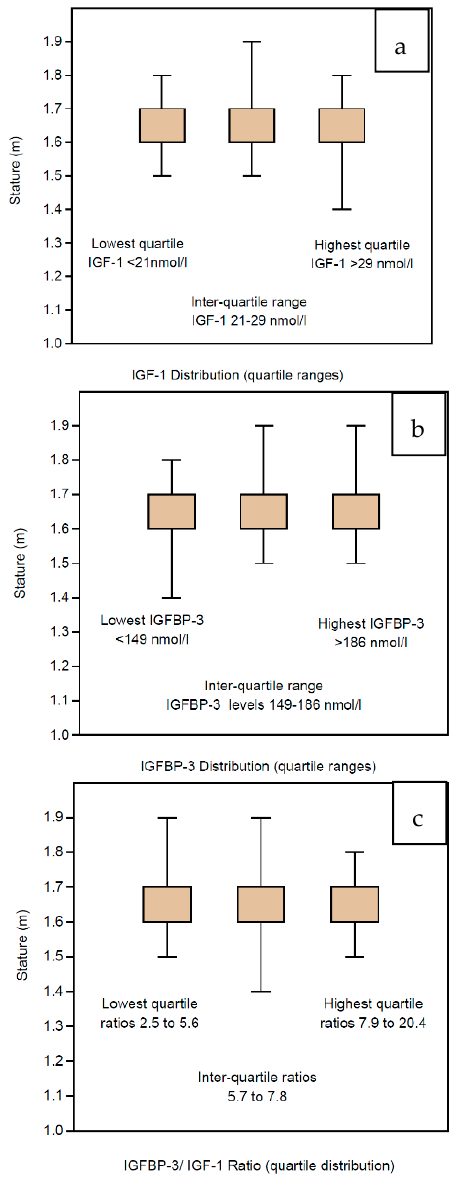
Figure 5. Box and whisker figures displaying the quartile distribution of IGF profiles for the 1633 women according to their stature measured in meters. There are no significant differences in stature across the quartiles for IGF-1 ( a ), IGFBP-3 ( b ) or the IGF Ratio ( c ). Table 4. Summary statistics are shown for the 1633 women with IGF profiles stratified according to their stature and depicted in Figure 5. The IGF-1 levels are shown for six height categories ranging from 1.4 m to 2.0 m in as well according to their centile ranges in Table 4. Similarly, the IGFBP-3 levels are shown for the six height categories ranging from 1.4 m to 2.0 m as well as according to their centile ranges in Table 4. Finally, the IGFBP-3/IGF-1 ratios are shown for the six height categories ranging from 1.4 m to 2.0 m as well as according to their centile ranges in Table 4.